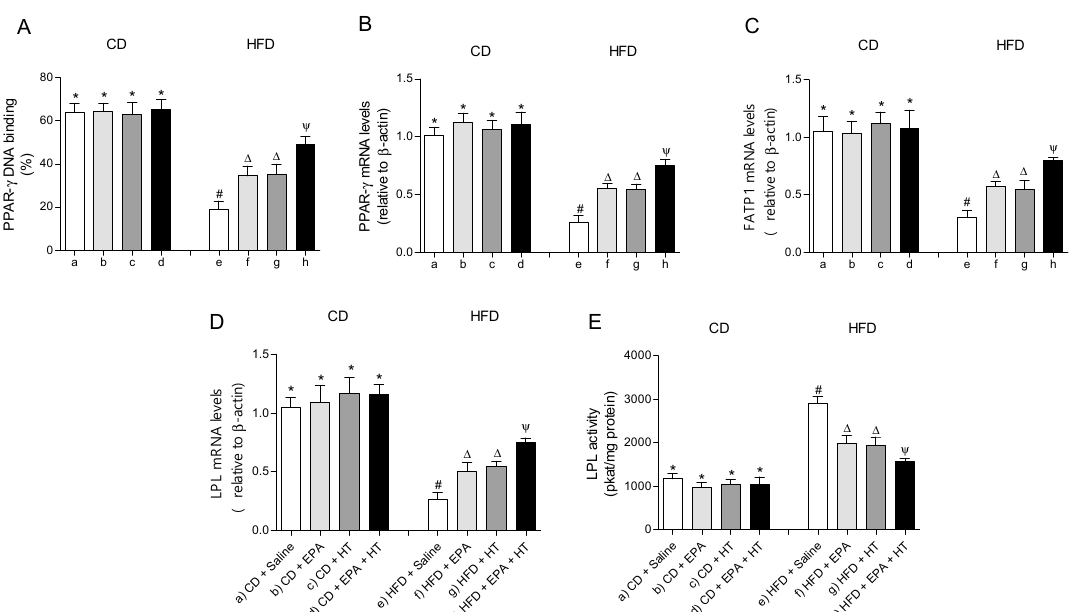
Figure 4. Peroxisome proliferator-activated receptor-gamma (PPAR- γ ) DNA-binding, ( A ) mRNA levels of PPAR- γ , ( B ) fatty acid transport protein 1 (FATP1), ( C ) lipoprotein lipase (LPL) ( D ) and LPL activity ( E ) in epididymal white adipose tissue from mice subjected to control diet (CD) and high-fat diet (HFD) supplemented or not with eicosapentaenoic acid (EPA), hydroxytyrosol (HT) or EPA + HT. Values are expressed as mean ± SD. Eight to ten mice were included in each experimental group. Groups that do not share the same superscript symbol were significantly di ff erent among them, namely, (a), CD + saline; (b) CD + EPA; (c) CD + HT; (d) CD + EPA + HT; (e), HFD + saline; (f) HFD + EPA, (g) HFD + HT; and (h), HFD + EPA + HT, according to two-way analysis of variance (ANOVA) followed by the Tukey’s post-test, p < 0.05. ( * ), does not di ff er from (a) group; ( # ), di ff er from (a) group; ( ∆ ), di ff er from (a) and (e) groups; ( Ψ ), di ff ers from groups (a), (e) and those marked with the symbol ∆ .